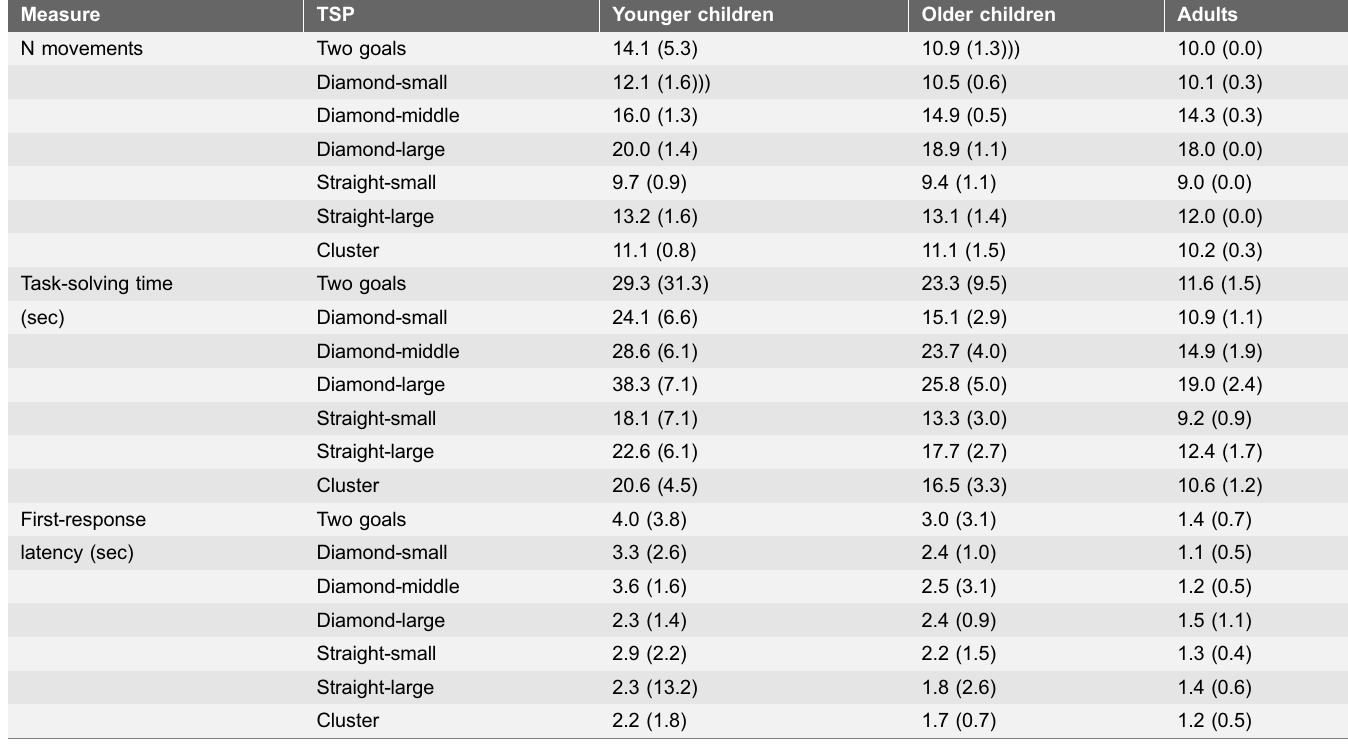
Table 1. Measures of performance on each TSP